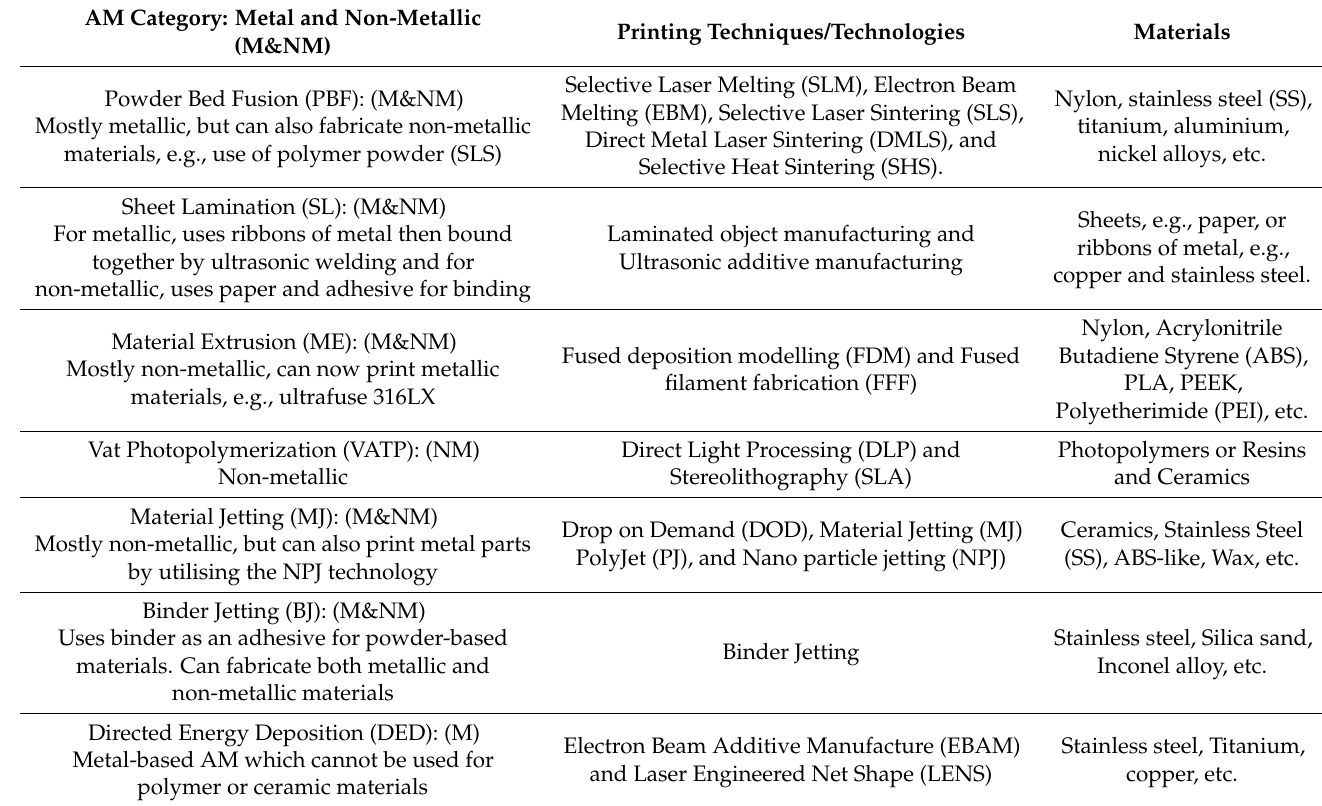
Table 1. Summary of Additive manufacturing (AM) categories and techniques from reviewed literature